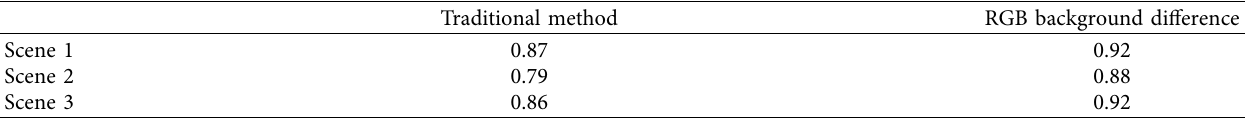
Table 2: Accuracy comparison.